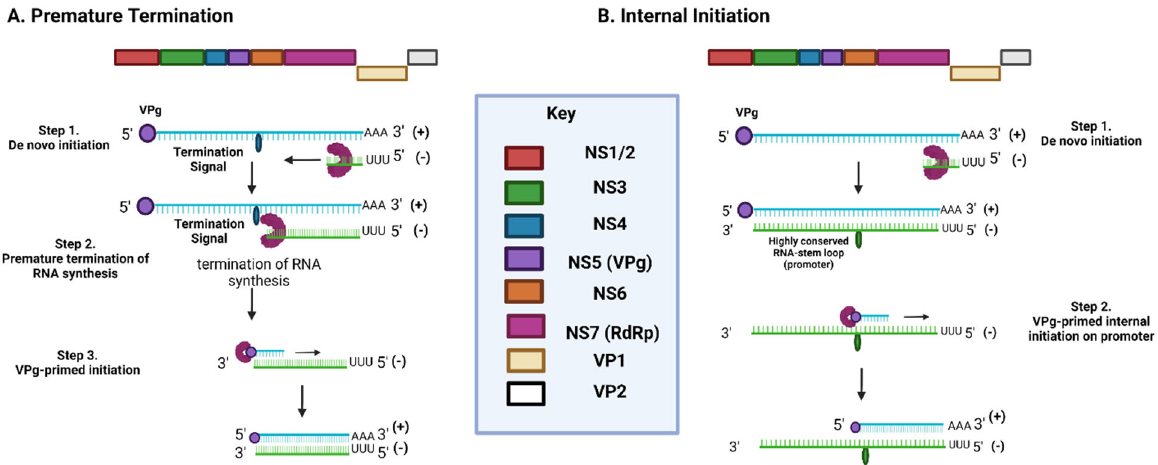
Figure 5. Two models for subgenomic RNA formation. The premature termination model suggests that a termination signal within genomic RNA results in early termination during de novo initiation replication. On the other hand, the internal initiation suggests that a highly conserved RNA-stem loop upstream of ORF2 is responsible for early termination of de novo initiation replication. The short antisense RNA strands produced then undergo VPg-primed initiation to form positive sense subgenomic RNA. Image made in biorender.com accessed on 18 October 2022 .